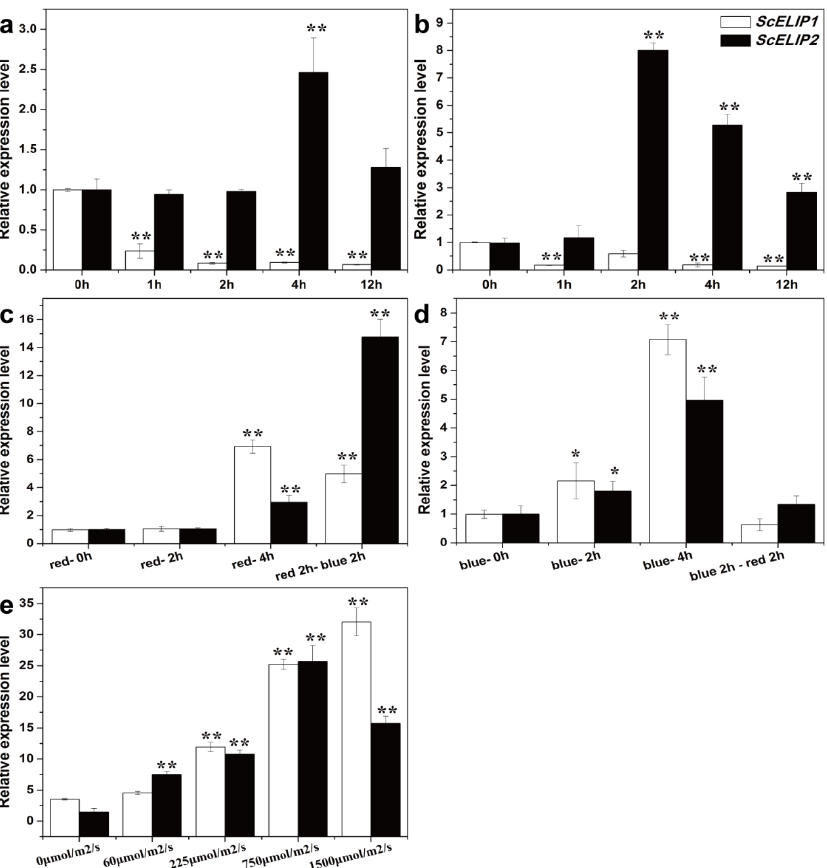
Figure 2. ScELIP1 and ScELIP2 transcript relative abundance assessments in Syntrichia caninervis gametophores exposed to various light treatments. The mean (each column) and SD (error bar) were calculated with three biological replicates and three technical replicates of each biological replicates.